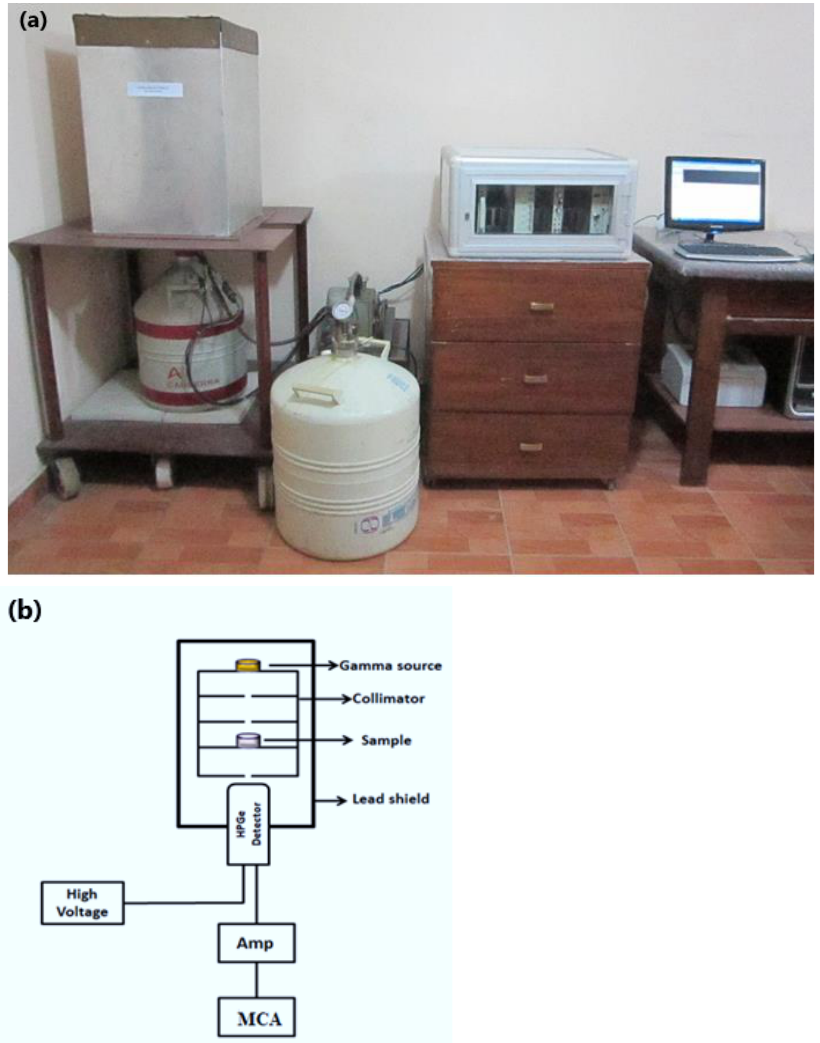
Figure 3. ( a ) HPGe detector accompanied by lead castles and electronic systems. ( b ) Schematic diagram of the experiment setup.